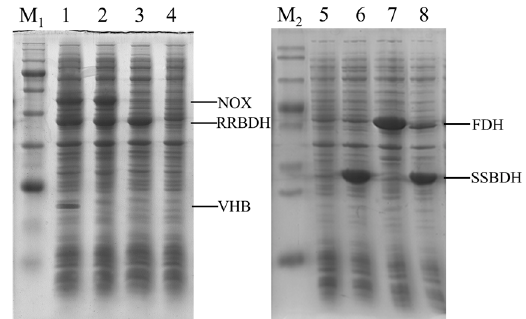
Figure 2. Expression analysis of recombinant E. coli strains by SDS-PAGE. Lane M 1 , marker proteins (180, 140, 100, 80, 60, 45, 35, 25, 15, 10 kDa); Lane 1, E. coli (pET- rrbdh - nox - vgb ); Lane 2, E. coli (pET- rrbdh - nox ); Lane 3, E. coli (pET- rrbdh ); Lane 4–5, E. coli (pET28a); Lane M 2 , marker proteins (120, 100, 70, 50, 40, 30, 25, 14 kDa); Lane 6, E. coli (pET- fdh ); Lane 7, E. coli (pET- ssbdh ); and Lane 8, E. coli (pET- ssbdh - fdh ). Table 1. Activity assays of (2 R ,3 R )-2,3-BDH and NADH oxidase in the recombinant E. coli strains. E. coli BL21(DE3)